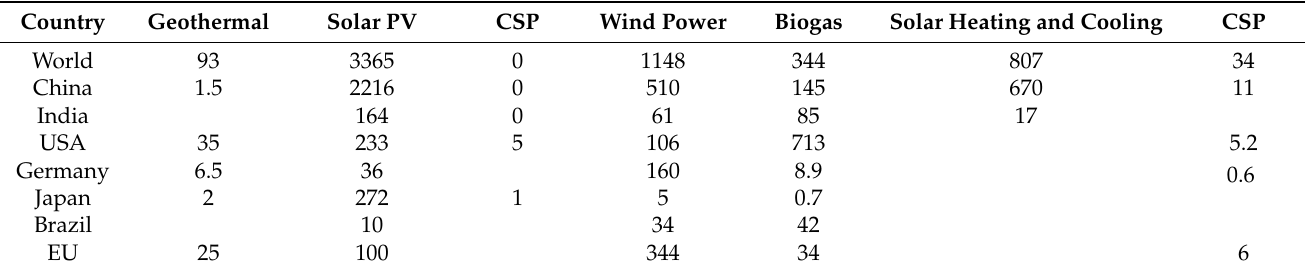
Table 3. The global approximated direct and indirect job opportunities in renewable energy by industry in 2016 – 2017 [ .